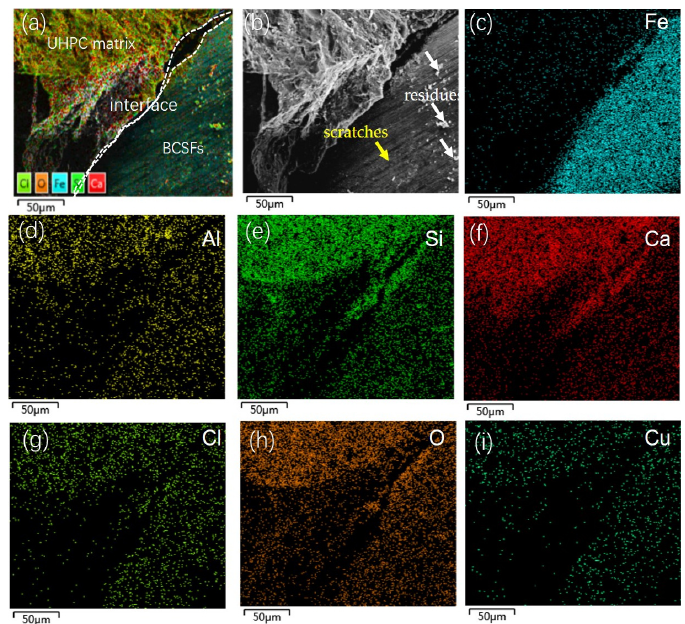
Figure 17. SEM and EDS images of interface of 6 wt.% straight BCSF-reinforced UHPC specimens at 28 days: ( a ) EDS imagine; ( b ) SEM imagine; ( c ) Fe; ( d ) Al; ( e ) Si; ( f ) Ca; ( g ) Cl; ( h ) O; ( i ) Cu. 3.7. Crack Expansion of Straight BCSF-Reinforced UHPC The relationship between BCSF bridging and matrix softening is shown in Figure 18.